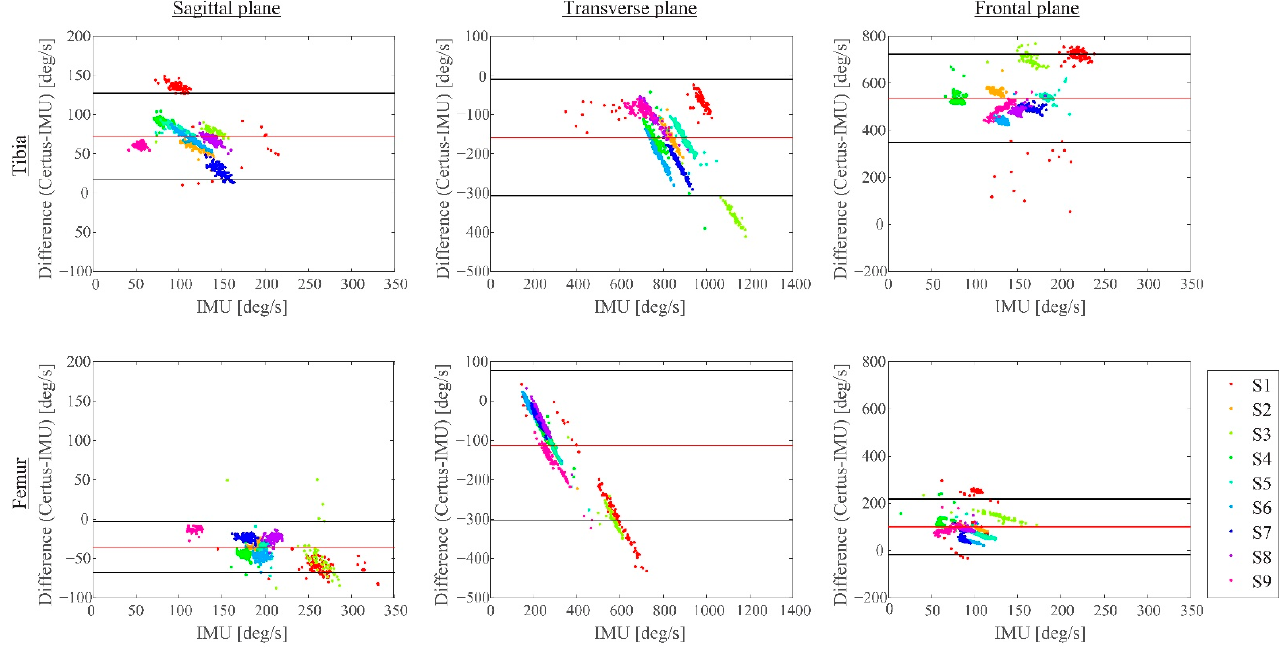
Figure 4. Bland–Altman plots showing differences, by plane, between Certus system and IMU in the angular velocity change for the tibia (top row) and the femur (bottom row). The x-axis shows the angular velocities measured via the IMUs, whereas the y-axis shows the difference in angles for each plane (left, center, and right panels). The bias was negative in the transverse plane, positive in the frontal plane, and mixed in the sagittal plane for the two bones.